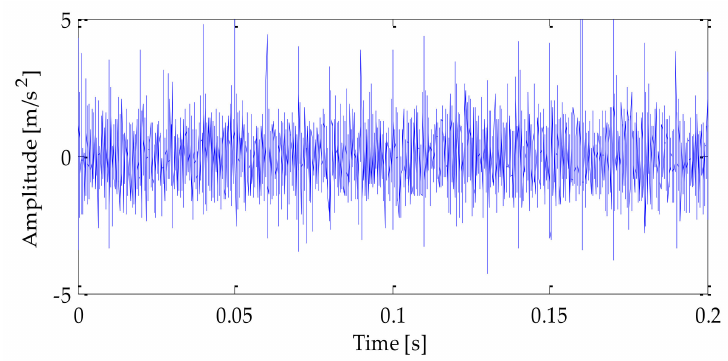
Figure 14. EMD–RobustICAnoise-reduction